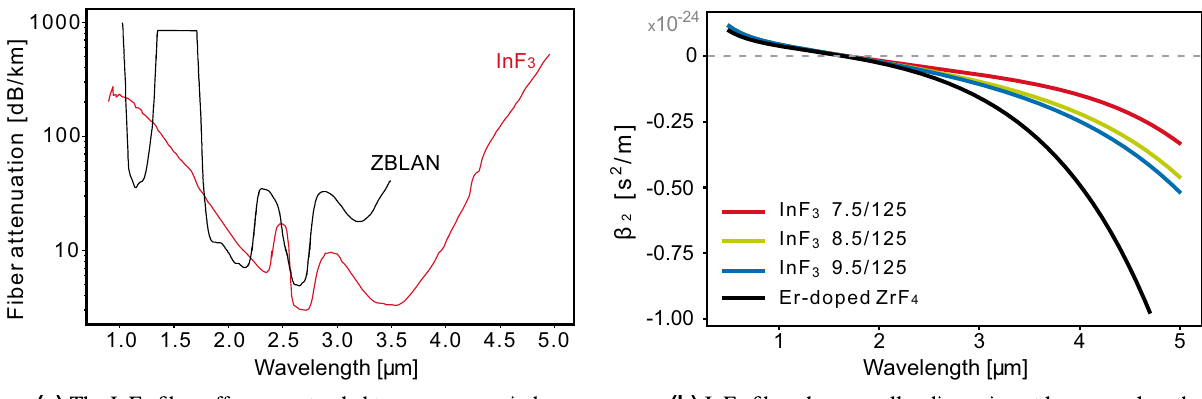
Figure 14. InF 3 fibers have better physical properties than ZBLAN for SSFS in the